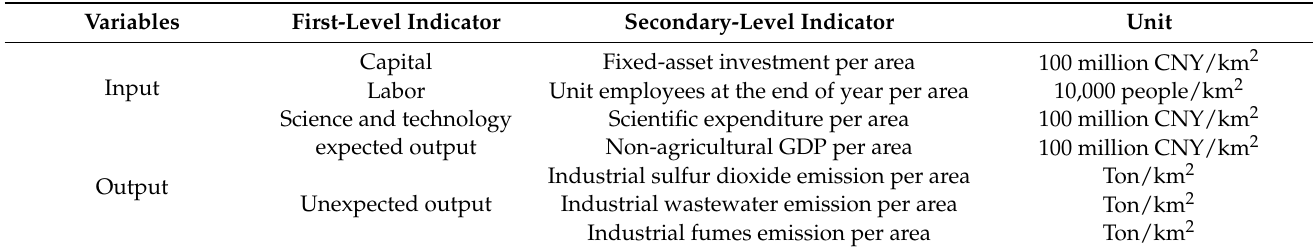
Table 1. Evaluation index system of